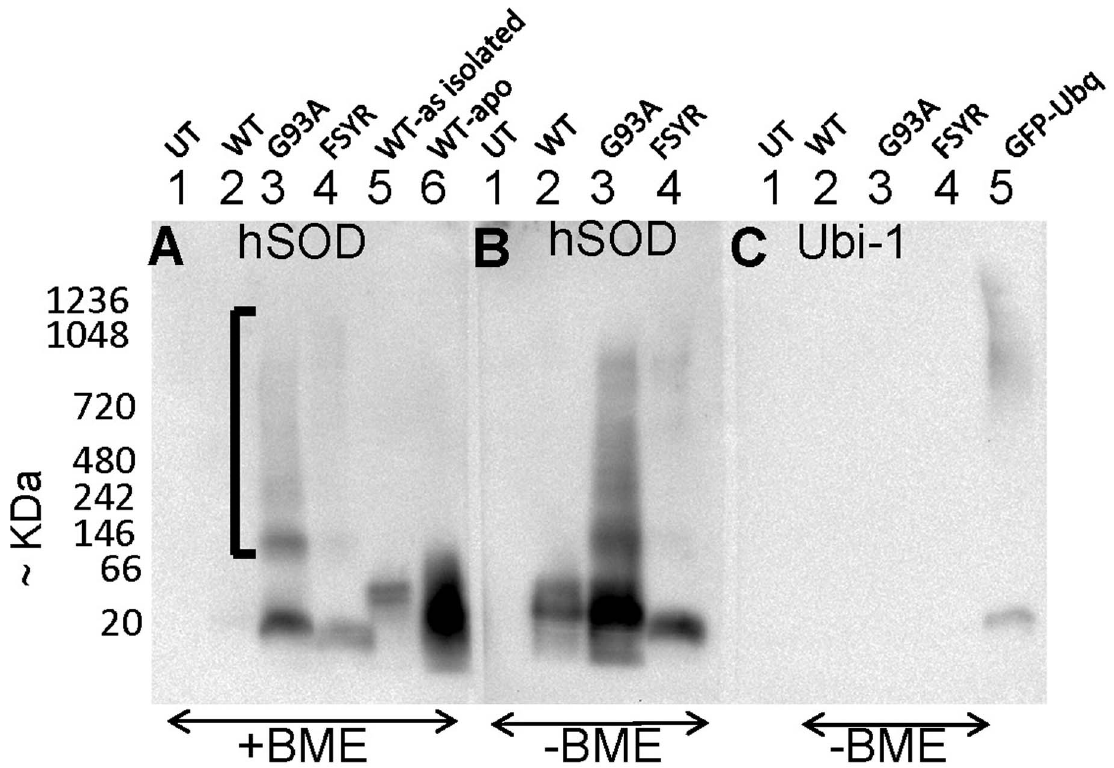
Figure 3. Disulfide crosslinking of mutant SOD1 contributes to electrophoretic heterogeneity. HEK293FT cells were transiently transfected with expression vectors for WT and mutant SOD1. After 24 hours, soluble extracts of the cells were prepared by lysis in digitonin, analyzed by BNGE, and immunoblotted with the antibody identified on the figure. ( A ) A portion of the cell lysate was treated with 2-mercaptoethanol (final concentration 1%) before electrophoresis. Gels containing samples treated with 2-mercaptoethanol (BME) were transferred separately from gels containing untreated samples. ( B and C ) A portion of the cell lysate was analyzed without BME treatment and immunoblotted with either antibody to SOD1 or antibody to ubiquitin. After transfer, the membranes were air dried to fix proteins to the membrane and then incubated with primary and secondary antibodies in parallel, with all three membranes imaged simultaneously. Treatment with 2-mercaptoethanol reduced amount of, but did not eliminate, slowly migrating G93A SOD1. A mutant form of SOD1 lacking all 4 cysteines produced low levels of slowly migrating forms of SOD1 immunoreactivity than the G93A mutant. The images shown are representative of at least 3 independent replications.